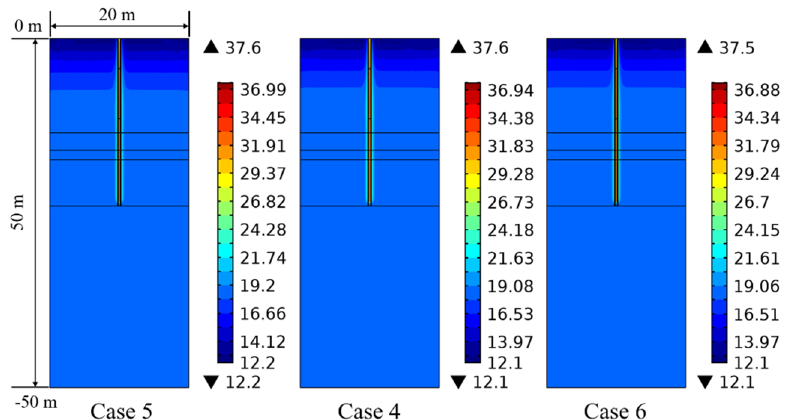
Figure 14. Effect of specific heat capacity of backfill soil in PHC pile on the ground temperature variation at 1 day (Units °C).